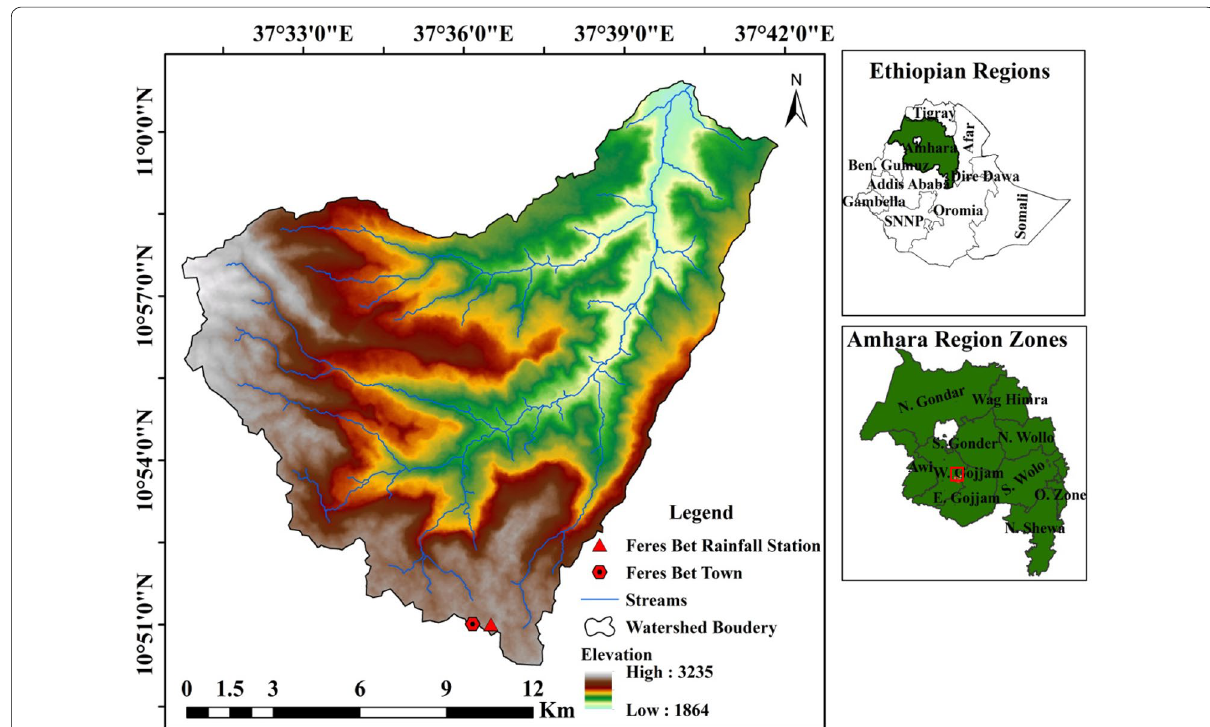
Fig. 1 Location map of Gumara